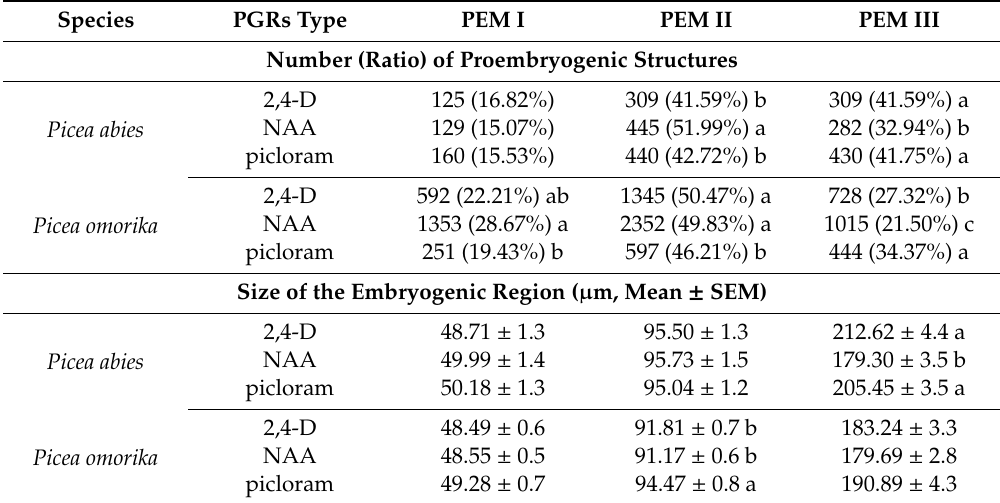
Table 4. The number (ratio) of proembryogenic structures and the mean size of the embryogenic region ( µ m, mean ± standard error). Di ff erent letters within columns indicate statistically significant di ff erences between means for PGRs type within species ( p < 0.05).